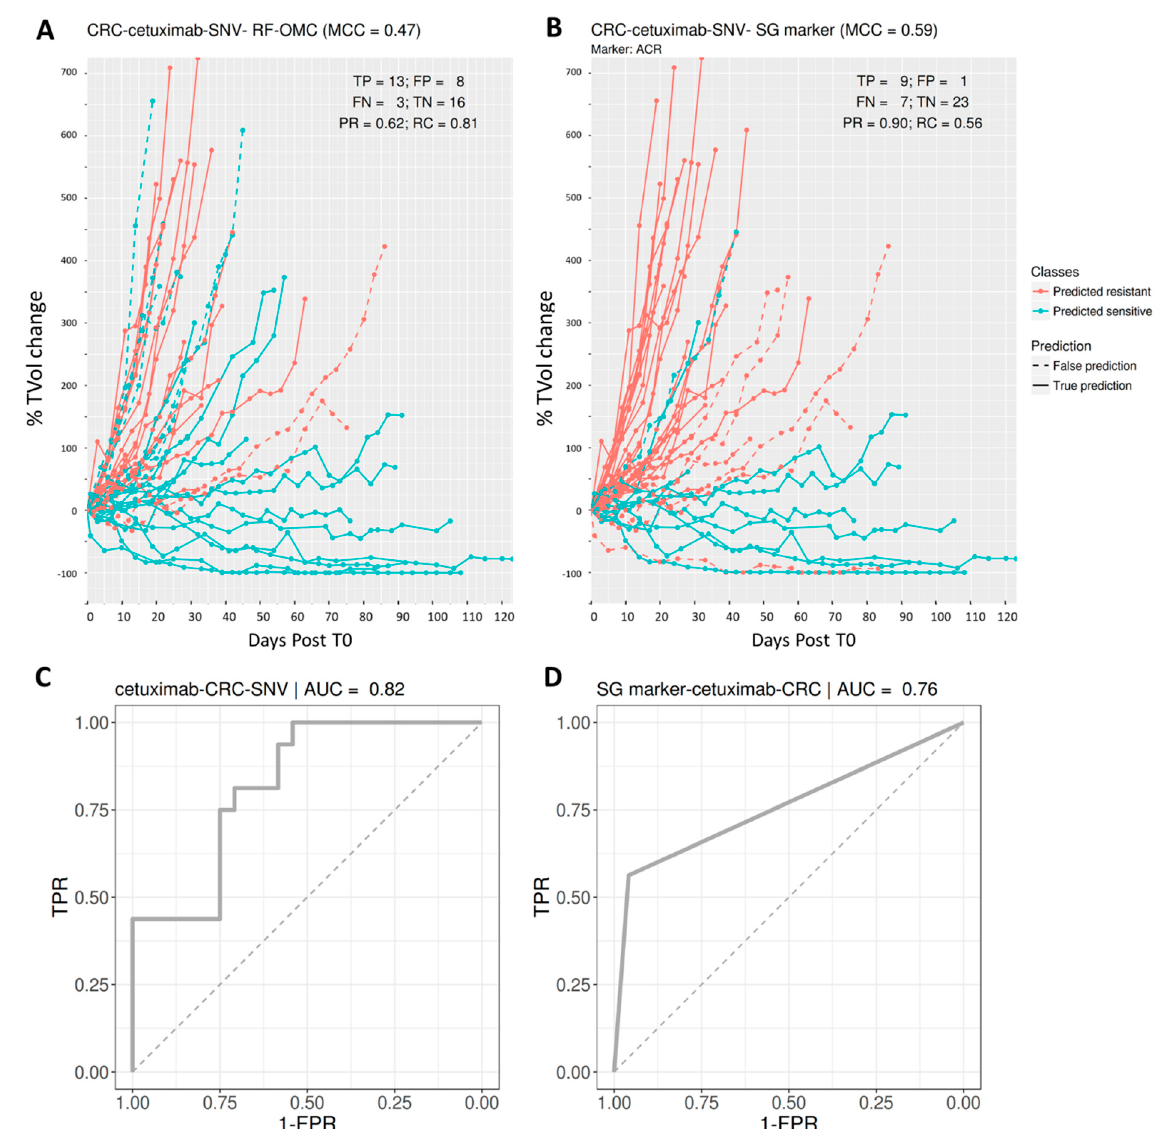
Figure 5. Predicting CRC PDX response to the EGFR inhibitor cetuximab. ( A , B ) Visualisation of tumour response prediction for test PDXs. ( A ) Cetuximab (4 fts) : RF-OMC predicts CRC tumour response to cetuximab by optimally combining the mutational states of four genes (ACR, DENND4B, NOTCH1 and RPL22). Again, a high level of predictive accuracy was